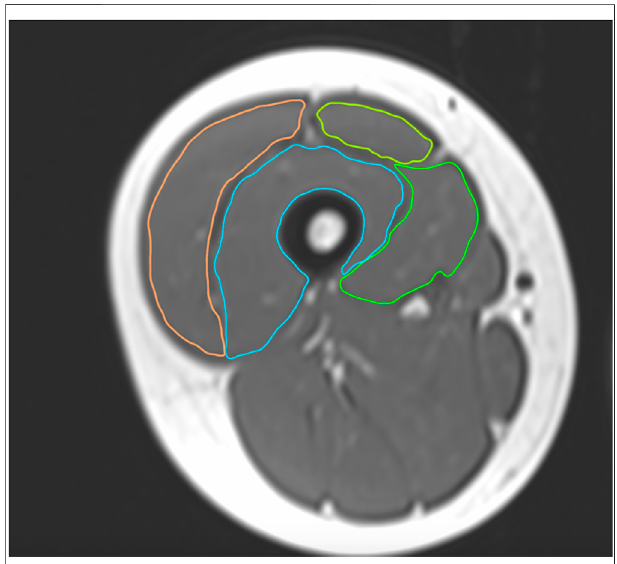
FIGURE2| Thecontouringprocessofthem.quadricepsfemorisforMV estimation of the individual muscle heads.